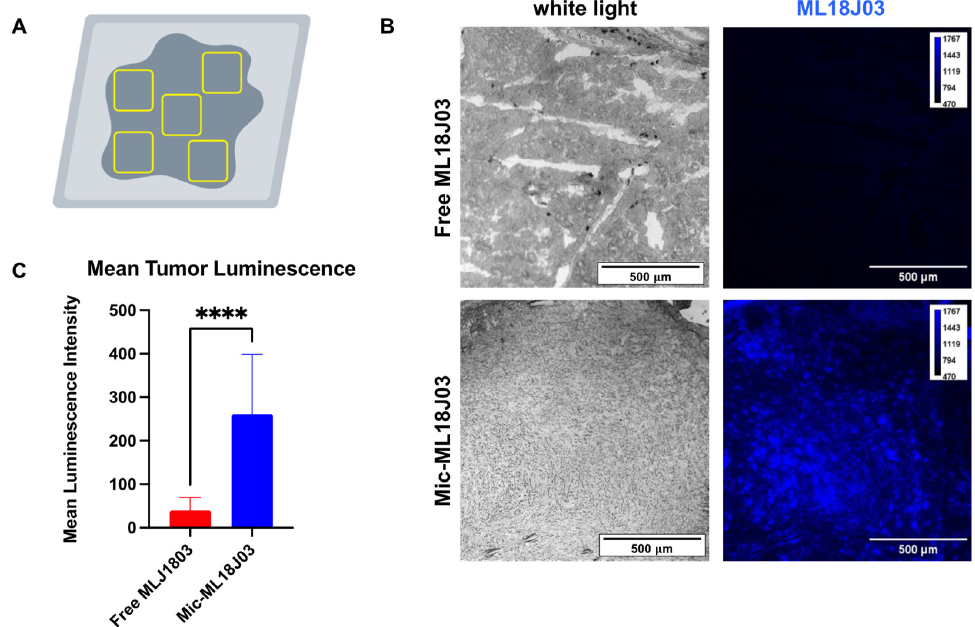
Figure 6. ( A ) Diagrammatic representation of the randomly sampled regions of interest (ROIs) across the entire tumor cross-section for mice administered with either Mic-ML18J03 or Free ML18J03. Representative white light and luminescence images ( B ; false color blue) and quantitative analysis ( C ) of tumor sections obtained from bisected AT-84 tumors 48 h following intravenous administration of free ML18J03 or Mic-ML18J03. (Images were processed using ImageJ; scale bar and calibration bar are represented) (All of the data is mean ± standard deviation; n = 3 (5 ROIs per tumor); statistical significance was calculated using a non-parametric two-tailed t -test, ****: p ≤ 0.0001).